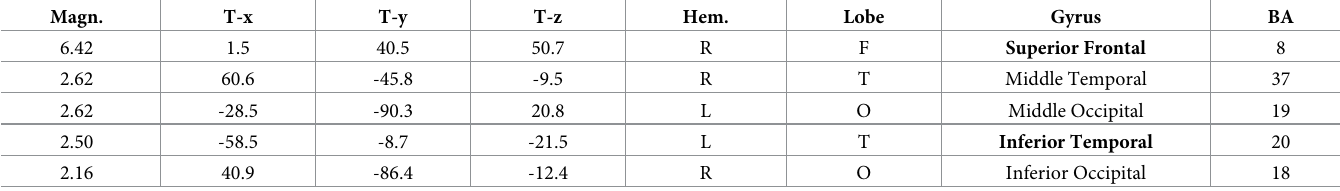
Table 4. Source reconstruction of N400 response to stereotype violation. Magn.